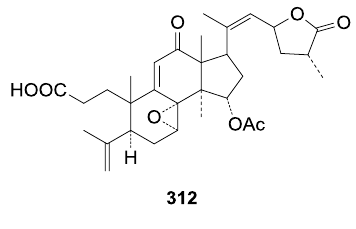
Figure 38. Structure of compound 312 .